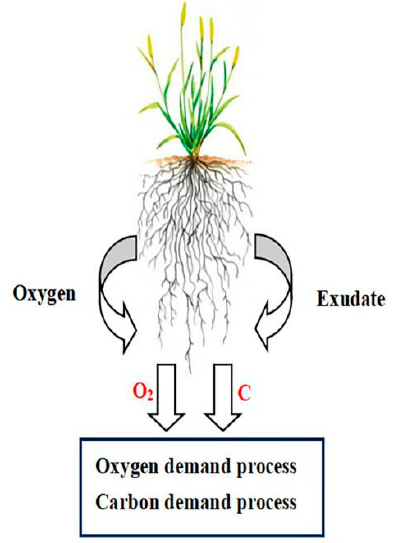
Figure 1. Oxygen supply by ROL and carbon source from root exudates in the root zone of the macrophyte.